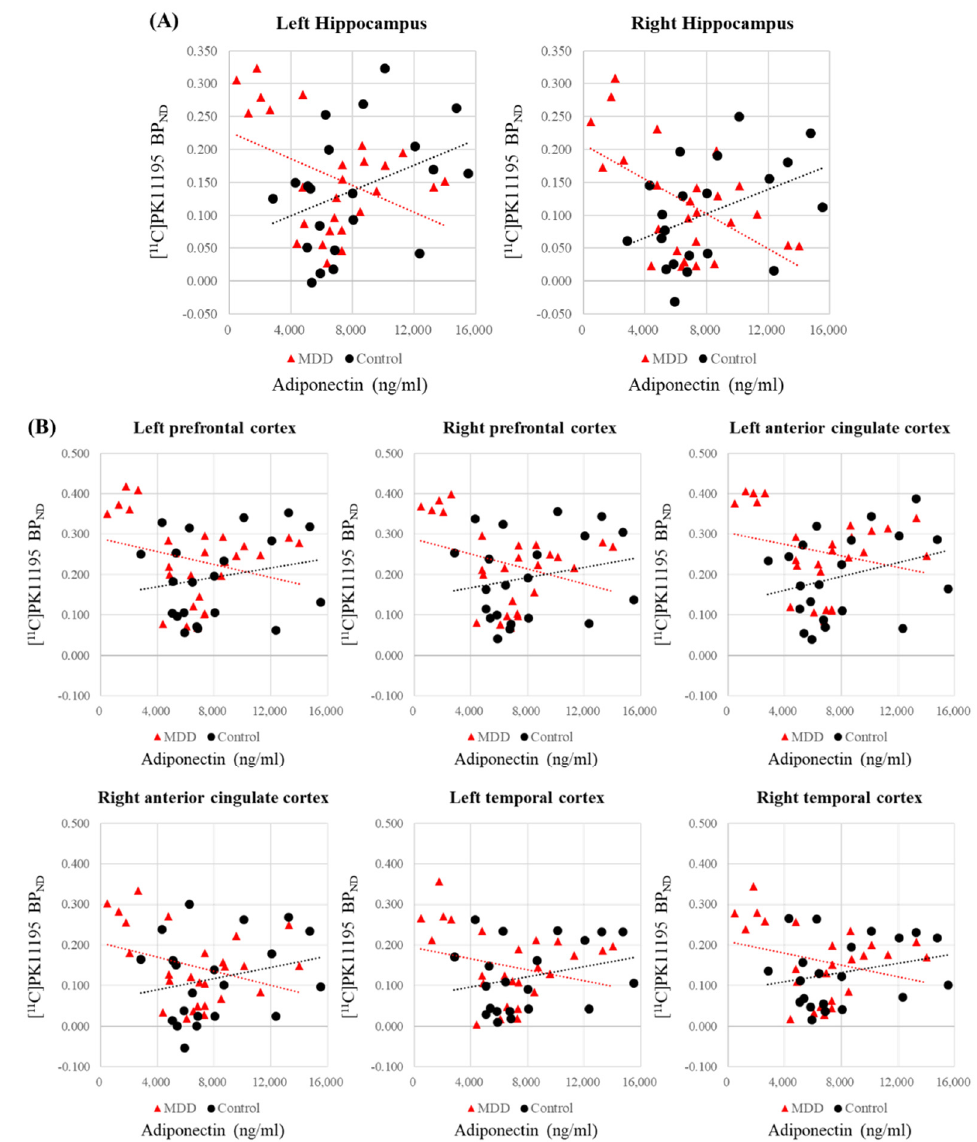
Figure 4. ( A ) Scatter plots of the correlation between serum adiponectin levels and [ 11 C]PK11195 BP ND values in the hippocampus for the MDD and control groups. The Fisher’s Z-transformation analysis revealed significant between-group differences in correlation coefficients (left hippocampus: z score = − 3.3, p < 0.001; right hippocampus: z score = − 4.2, p < 0.001). ( B ) Scatter plots of the correlation between serum adiponectin levels and [ 11 C]PK11195 BP ND values in the bilateral prefrontal, anterior cingulate, and temporal cortices. The Fisher’s Z-transformation analysis revealed sig- nificant between-group differences in correlation coefficients ( p < 0.05), indicating negative correla- tions in the MDD group and positive correlations in the control group. BP ND , binding potential with respect to non-displaceable compartment; MDD, major depressive disorder.